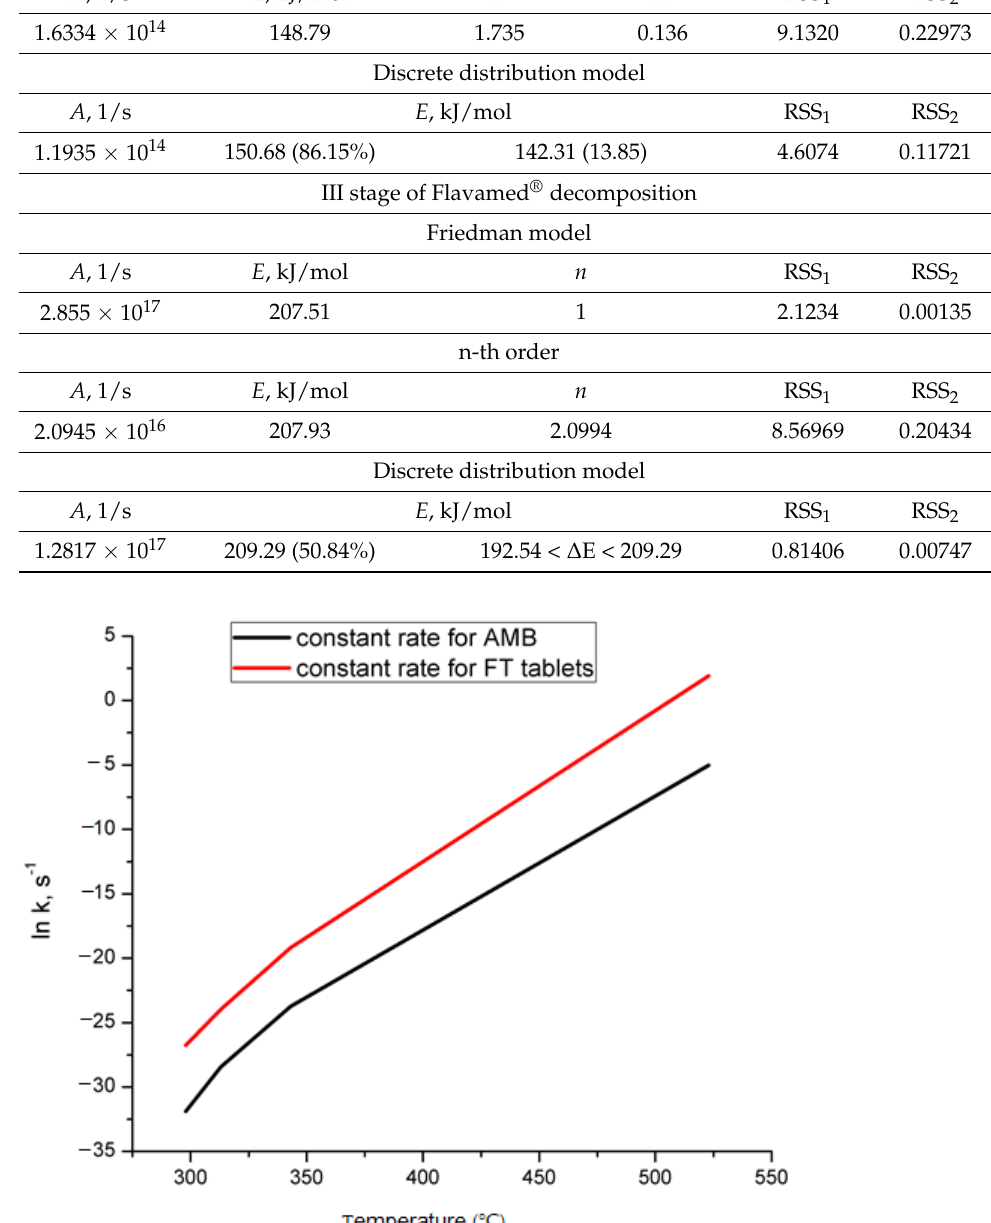
Figure 10. The dependence of constant rate vs. temperature for AMB and FT decomposition mech- anism.